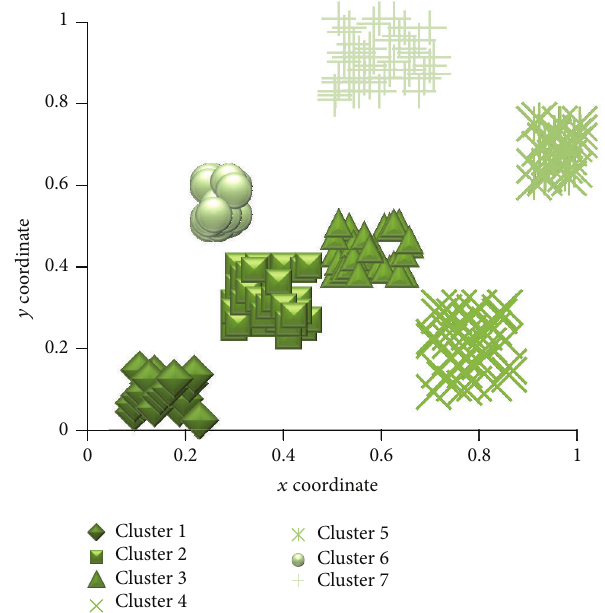
Figure 5: Clusters of agents obtained after applying Bluegill- BestPredictions